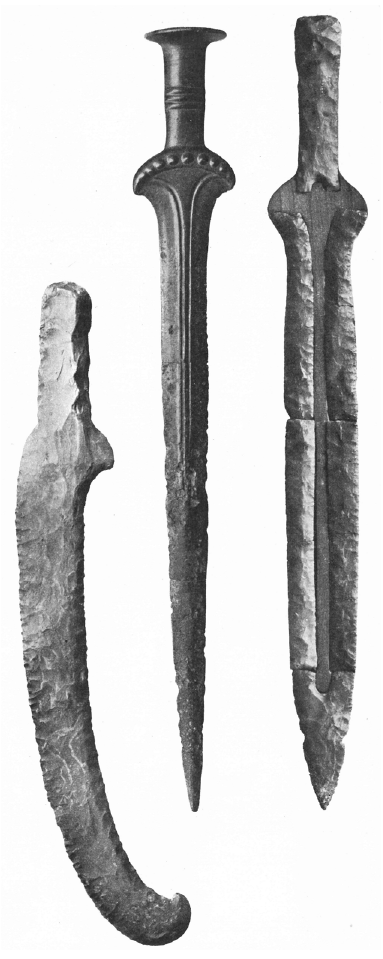
Figure 5. Flint scimitar (35.5 cm) from Favrskov on Funen, bronze and flint short swords (both 43 cm). The flint composite short sword consists of 6 pieces of flint (here mounted on a modern wooden framework) and derive from an Early Bronze Age burial mound at Åtte in southwestern Jutland. After Glob